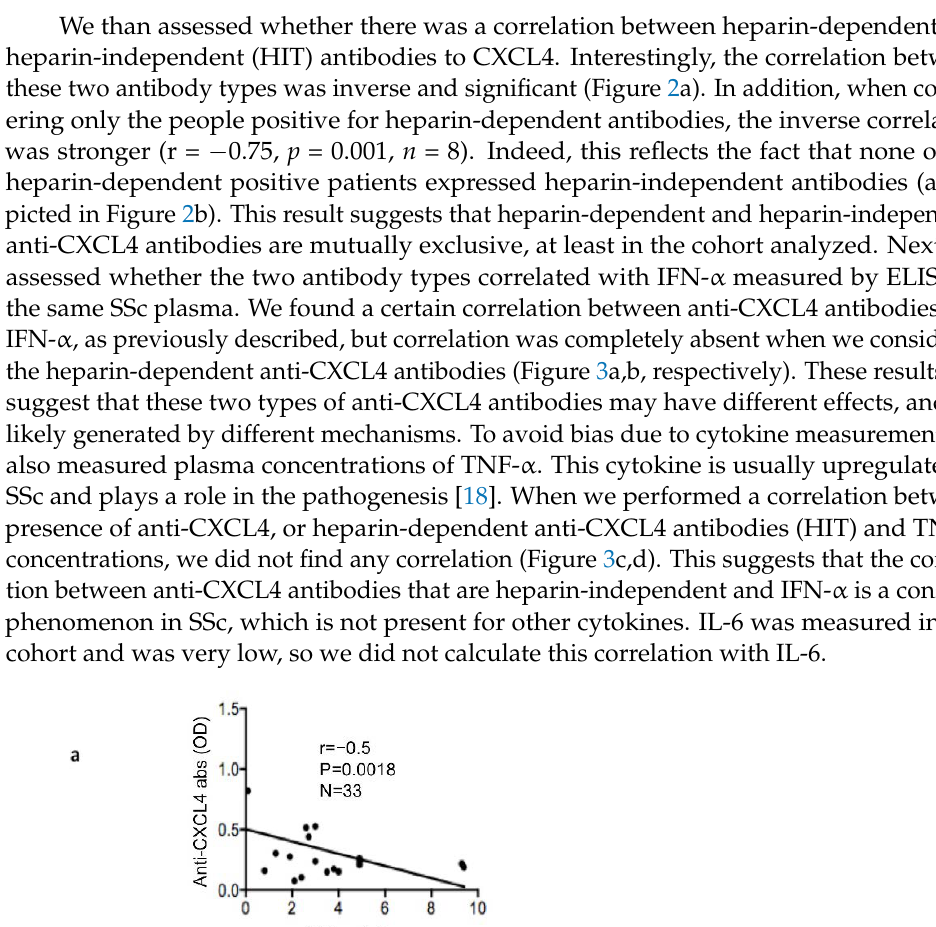
Figure 3. HIT antibodies do not correlate with IFN- α in plasma. Plasma of SSc was assessed for the positivity for IFN- α and TNF- α by ELISA (see methods). Values of IFN- α and TNF- α concentra- tions were plotted against values of anti-CXCL4 positivity ( a , c ) or amounts of HIT antibodies ( b , d ). Spearman’s correlation test was used to address correlation between these antibody types and IFN- α . The “r” coefficient of correlation, p (significance) and N (sample size) are reported on each graph.